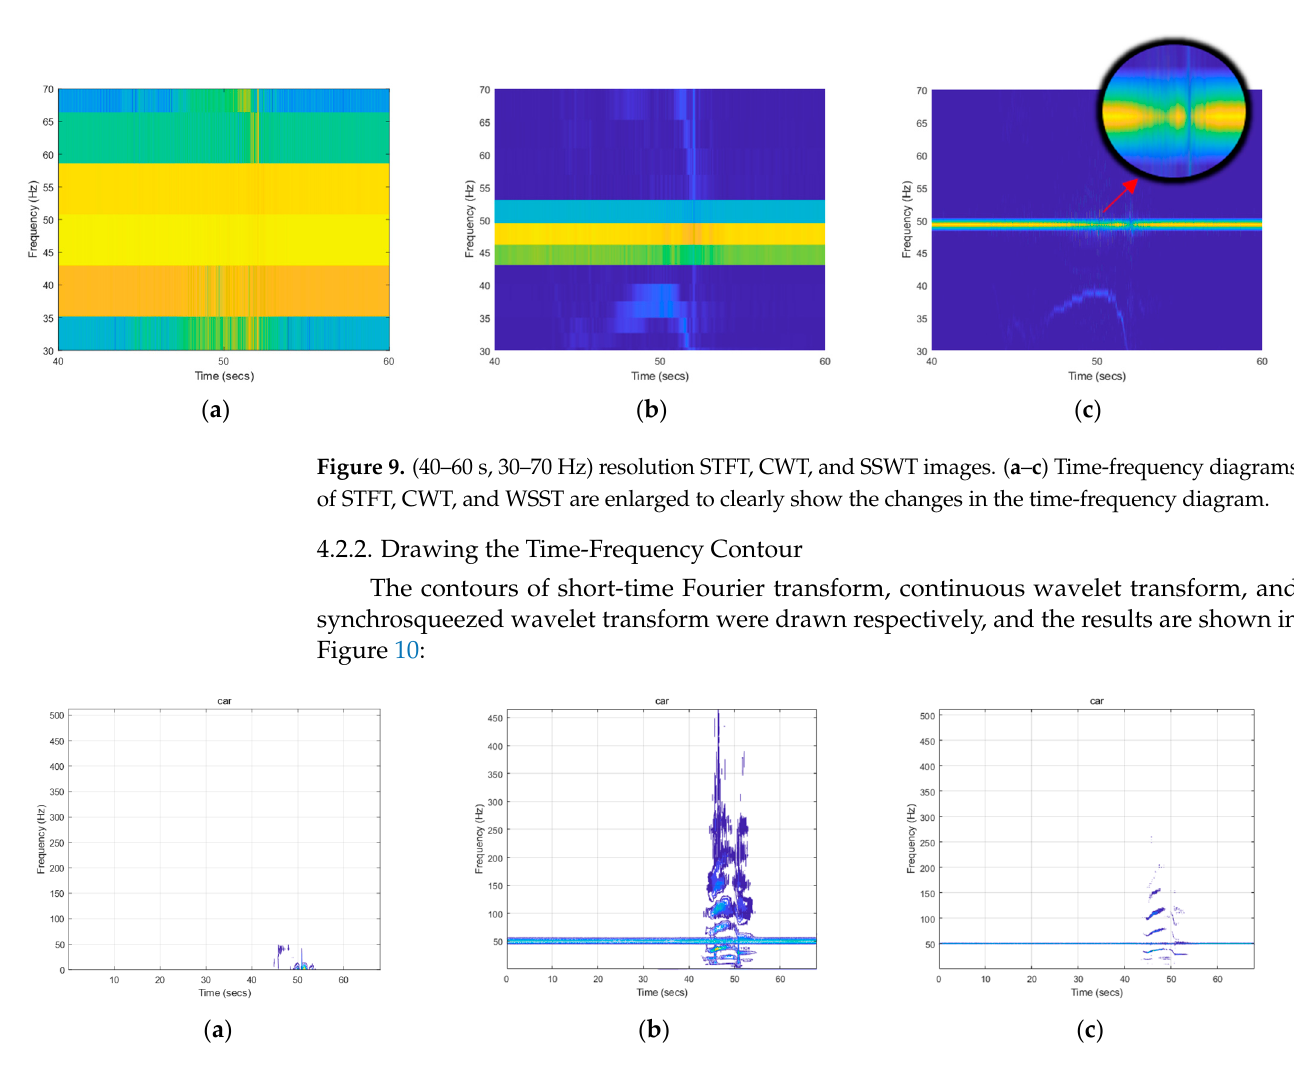
Figure 10. Draw spectral contour lines for STFT, CWT, SSWT; ( a – c ) are spectral contour lines for SFFT, CWT, and SSWT.